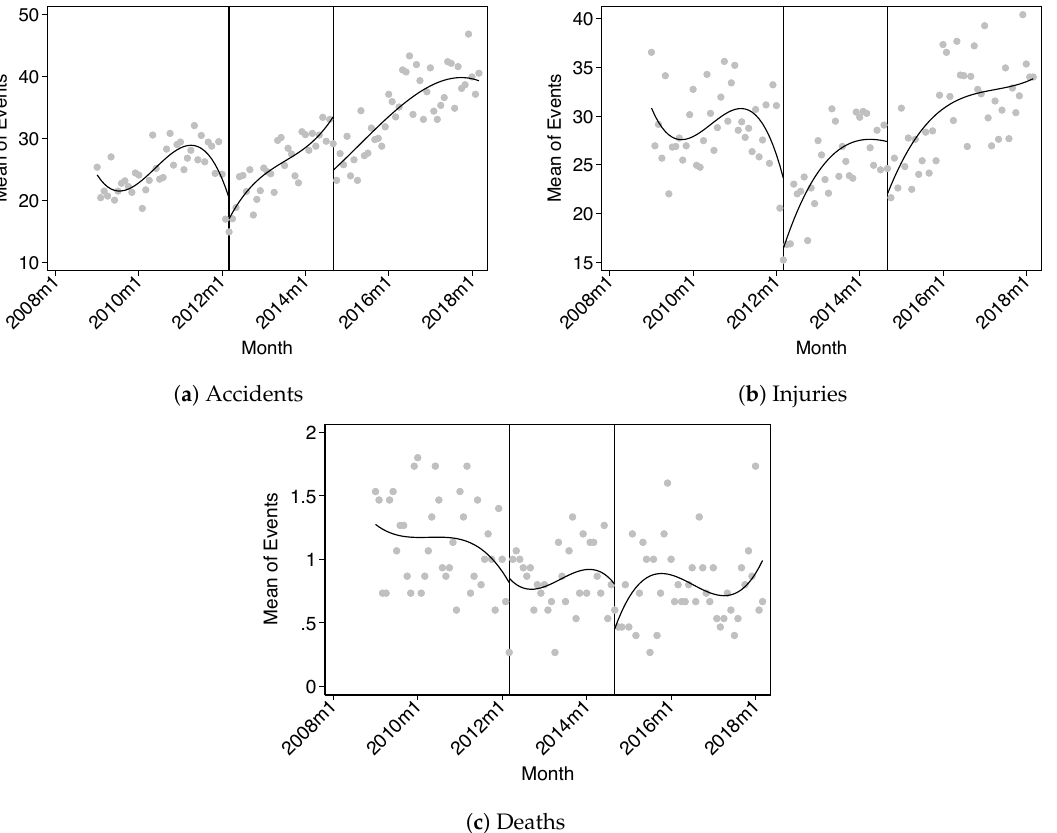
Figure 1. Plots for alcohol-related accidents, injuries and deaths, along with cubic fits. Each dot represents the regional average of events in a given month. The first and second vertical lines represent the enactment month of the Zero Tolerance Law (ZTL) and Emilia’s Law (EML),